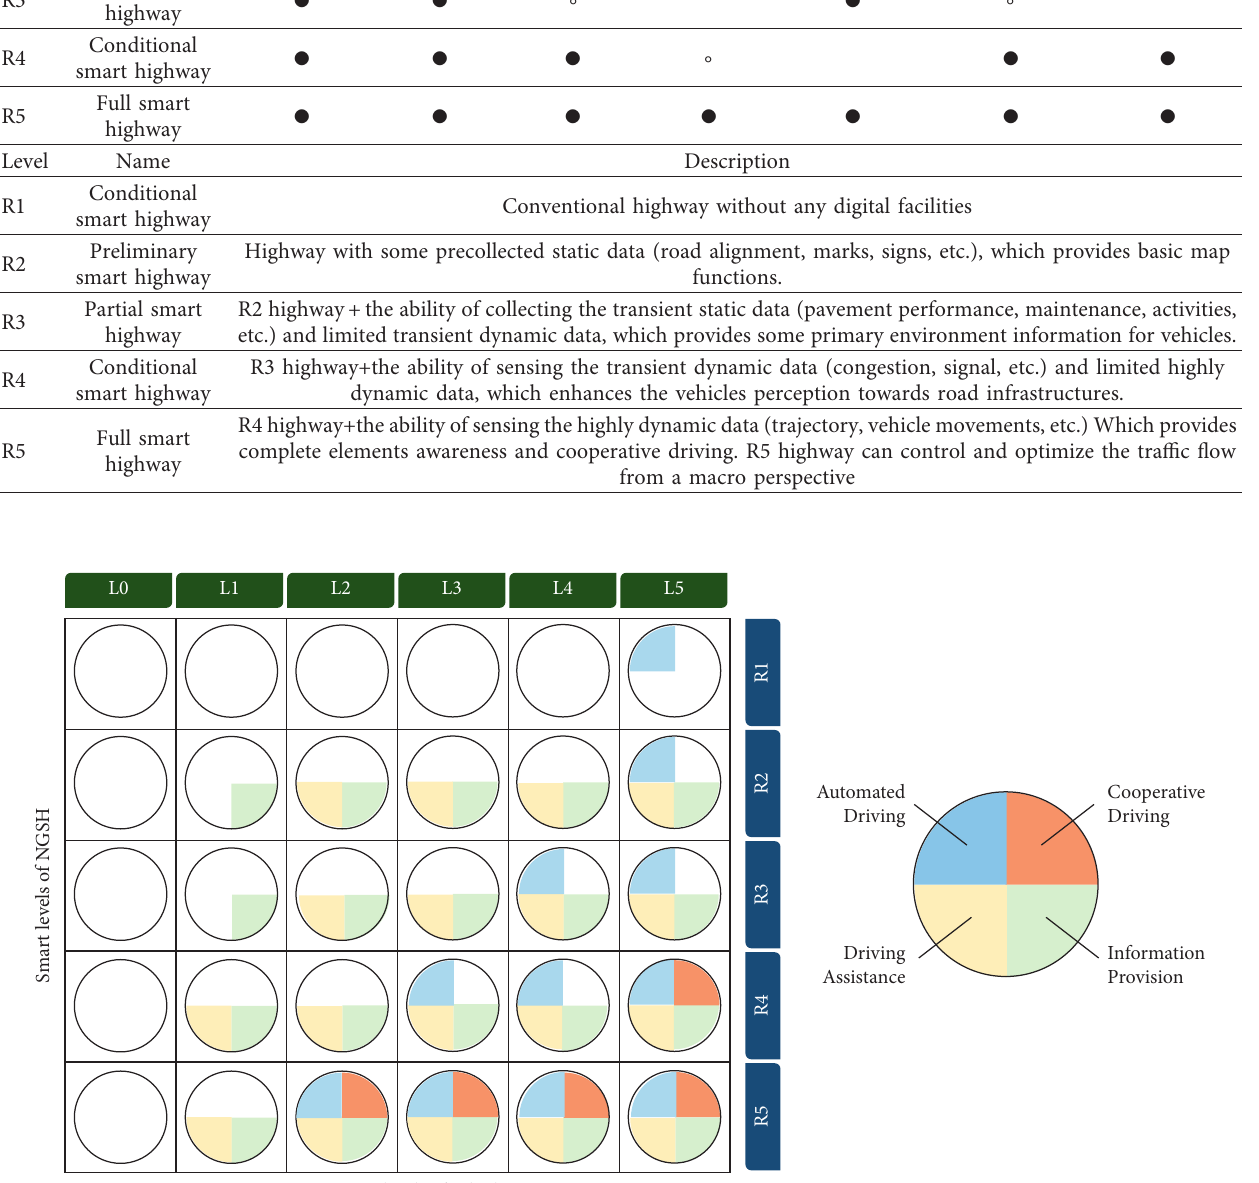
Figure 8: Combined effect of vehicle’s automated level and highway’s smart